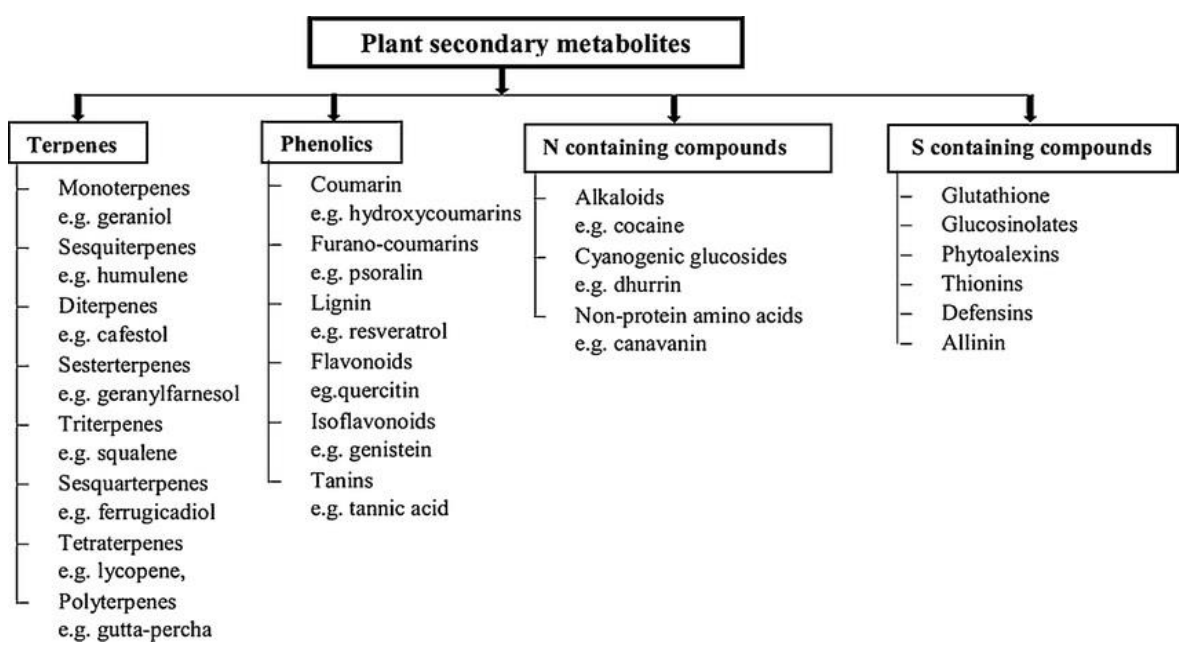
Figure 1. The four major types of secondary metabolites that have the major terpenes and phenolics. Phenolic compounds derive from the phenylpropanoid pathway in plants and they have diverse structures and supply flowers, fruits and vegetables with color. Alkaloids